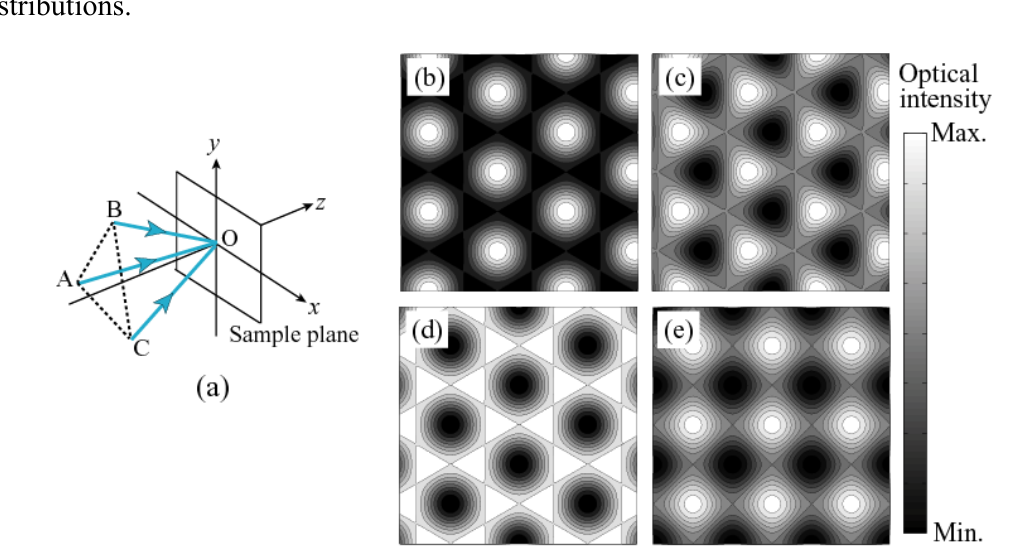
Figure 5. Typical interference patterns using three beams. ( a ) Optical arrangement; ( b ) hexagonal; ( c ) triangular; ( d ) inversed hexagonal; and ( e ) rectangular intensity